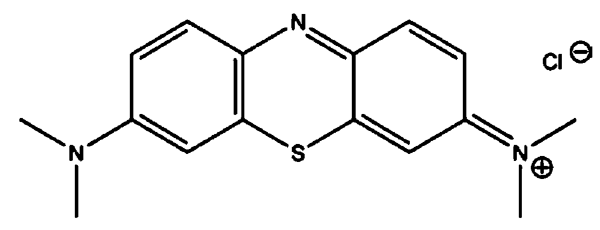
Figure 1. Chemical structure of the Methylene Blue Dye (MBD).